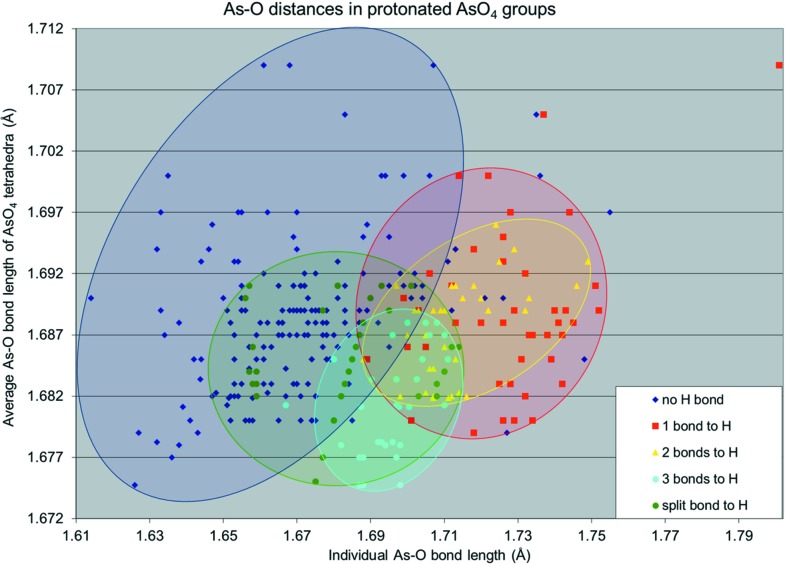
Comparison of As—O distances in HnAsO4 (n = 1–3) groups, sorted by As—OH bonds into clouds for H3AsO4 (turquoise), H2AsO4 (yellow) and HAsO4 (red) groups. As—OH bonds to split H-atom positions are shown in green, while all bonds to the remaining nonprotonated O atoms are shown in blue.